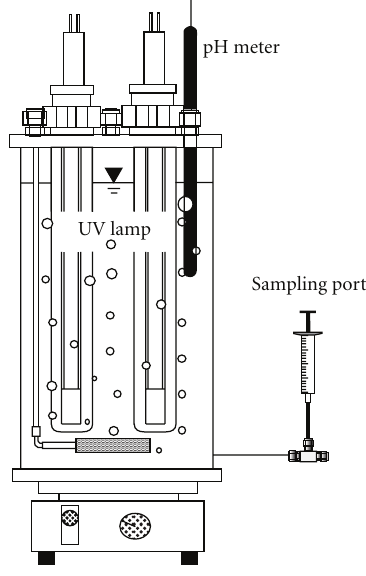
Figure 1: Experimental sketch of UV/TiO 2 /SiO 2 /Fe 3 O 4